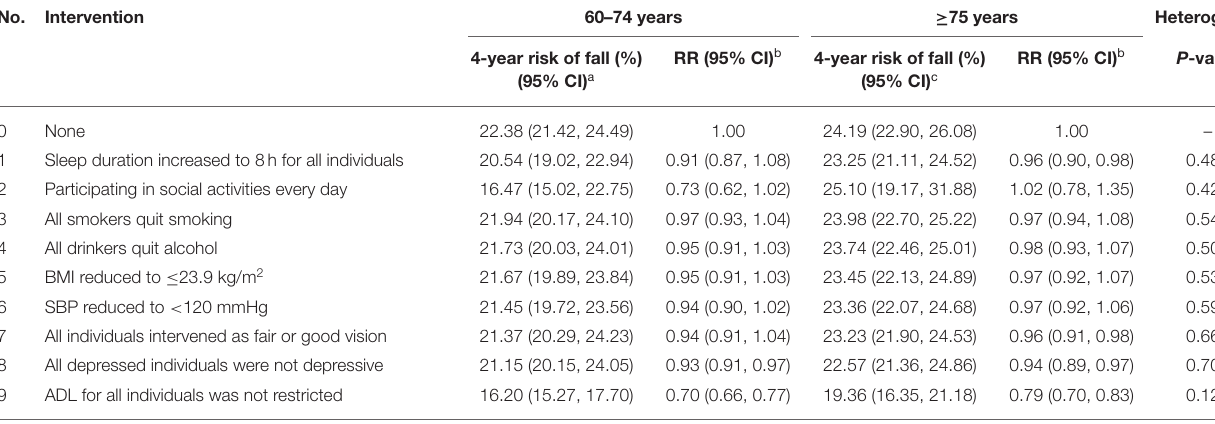
TABLE 6 | Risks of falls under single intensive interventions by age.